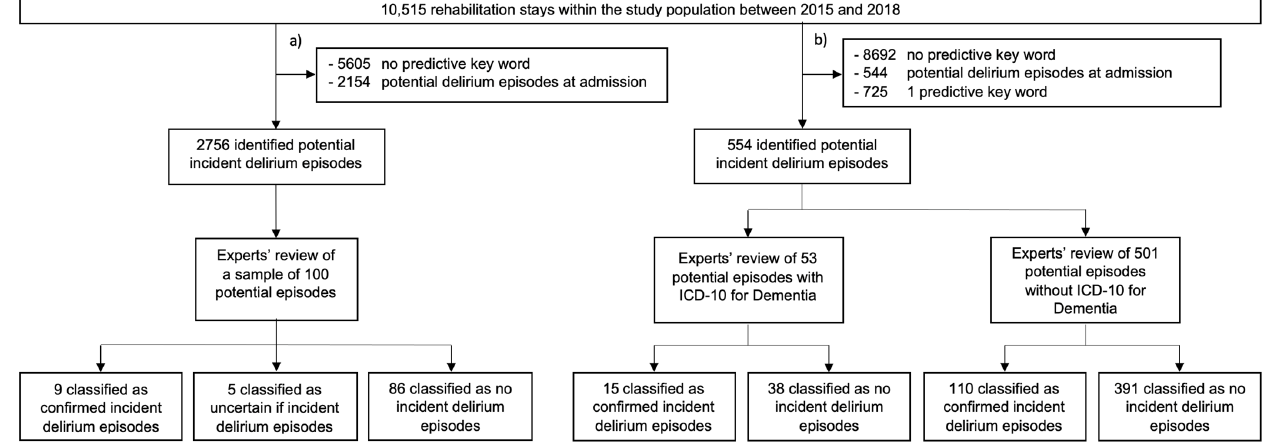
Figure 1. Selection and review process of potential incident delirium episodes within the initial population of rehabilitation stays: ( a ) Identification of patients based on the original delirium ‐ predictive key words list for the sample review (Table 1); ( b ) Identification of patients based on the modified delirium ‐ predictive key words list for the main review (Table 1).